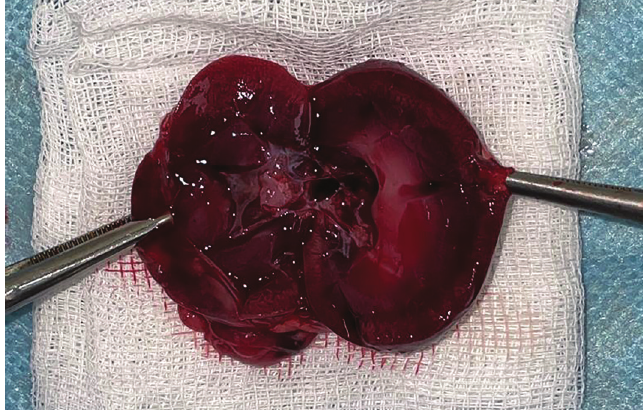
Figure 4 - Renal tissue sampling.